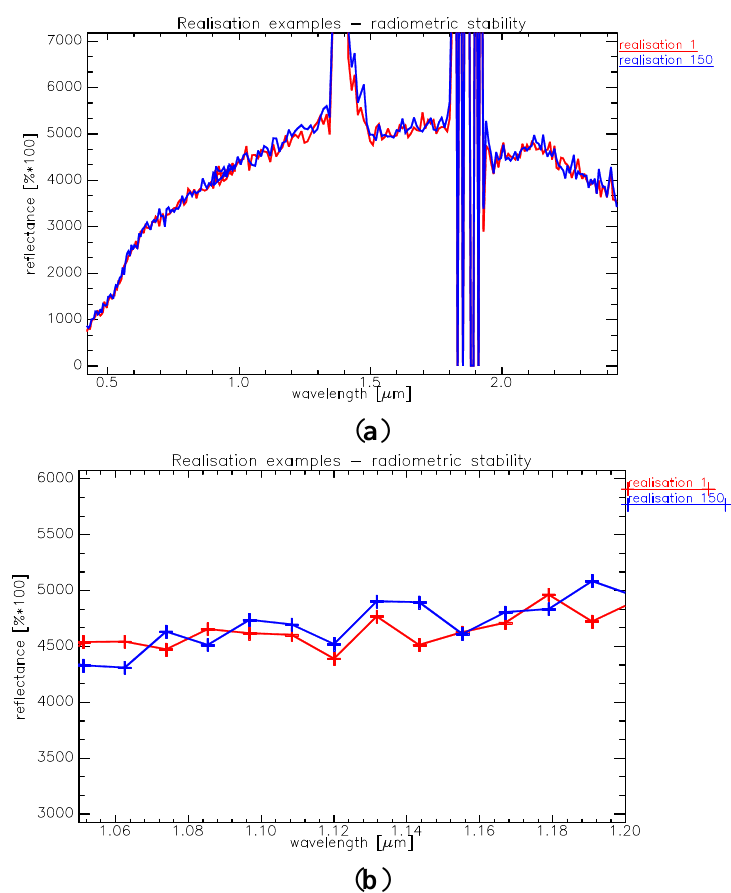
Figure 3. Plot of the reflectance spectra of two realizations of an image pixel; ( a ) full range; ( b ) zoom on the minor water vapour absorption feature at 1130 nm.